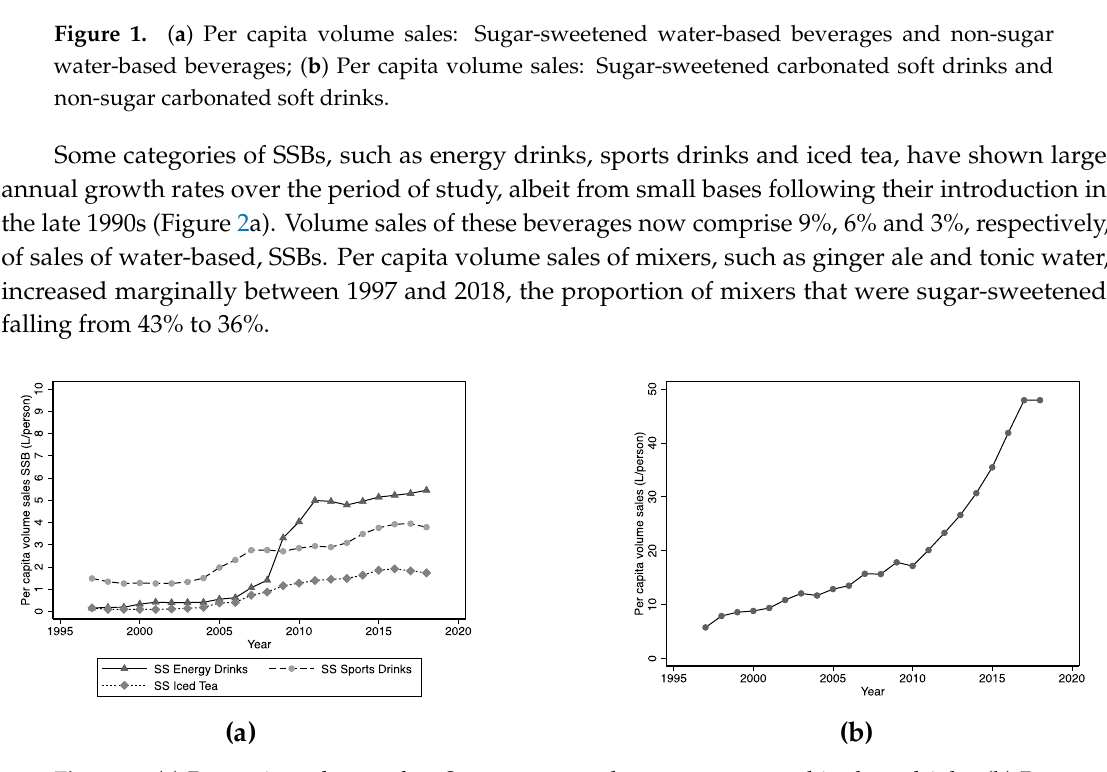
Figure 2. (a) Per capita volume sales: Sugar-sweetened sports, energy and iced-tea drinks; (b) Per capita volume sales: Pure still water (bottled water).